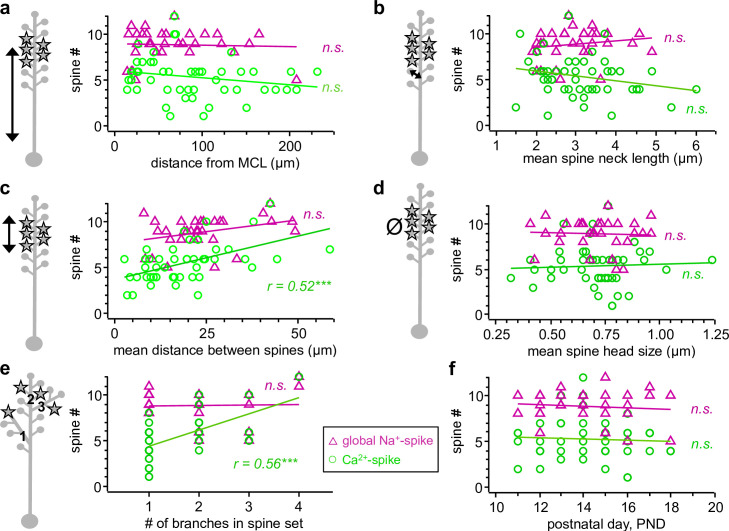
Impact of morphological variables on threshold spine number for Ca2+-spike and global Na+-spike generation.Ca2+-spike data (n = 47 spine sets) are denoted by green circles ○ and global Na+-spike data (n = 31 spine sets) by magenta triangles Δ. D-spike data not included for clarity (but see Table 1 and data repository). Linear correlation indicated by correlation coefficient r. See Table 1 for power of regressions. a: Influence of mean spine distance from the MCL on spine # to elicit Ca2+-spikes (r2 = 0.02, p = 0.17) and global Na+-spikes (r2 = 0.00, p = 0.89). b: Influence of the mean spine neck length of activated spine sets on spine # to elicit Ca2+-spikes (r2 = 0.03, p = 0.12) and global Na+-spikes (r2 = 0.00, p = 0.35). c: Influence of the spatial distribution of activated spines on spine # to elicit Ca2+-spikes (r2 = 0.26, p < 0.001) and global Na+-spikes (r2 = 0.08, p = 0.06). d: Influence of the mean spine head size (estimated diameter) that the spine set is distributed across on spine # to elicit Ca2+-spikes (r2 = 0.00, p = 0.75) and global Na+-spikes (r2 = 0.00, p = 0.86). e: Influence of number of different dendritic branches that the spine set is distributed across on spine # to elicit Ca2+-spikes (r2 = 0.31, p < 0.001) and global Na+-spikes (r2 = 0.00, p = 0.91). f: Influence of age of animal PND on spine # to elicit Ca2+-spikes (r2 = 0.00, p = 0.83) and global Na+-spikes (r2 = 0.00, p = 0.58). MCL, mitral cell layer; n.s., not significant; PND, postnatal day.